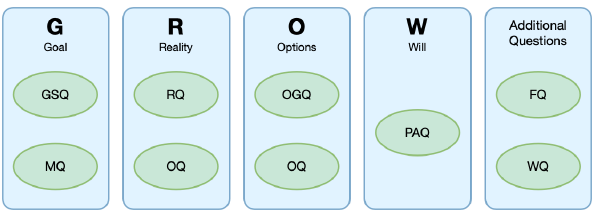
Figure 2. The structure of the GROW model of behaviour change [50].